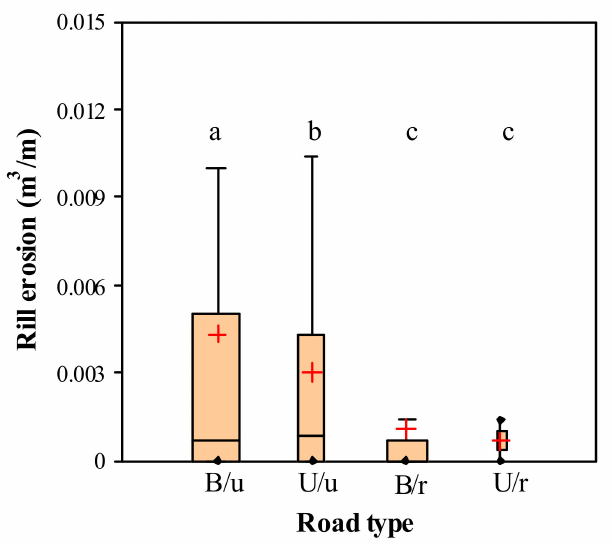
Figure 3. Box-Whisker plots of erosion volumes measured in rills of four road types in Hell í n (Central-Eastern Spain). Legend: B/u = Unpaved road in burned forest; B/r = Rock-paved road in burned forest; U/u = Unpaved road in unburned forest; U/r = Rock-paved road in unburned forest; red cross are the mean values; different lowercase letters indicate significant differences ( p < 0.05), according to